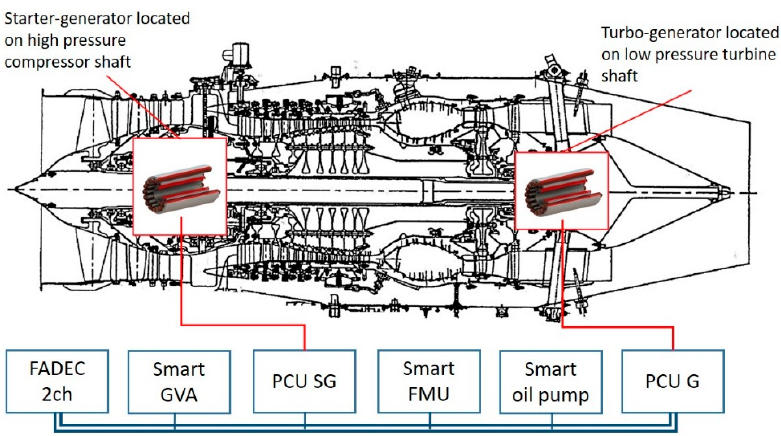
Figure 2. Medium size UAV engine concept .